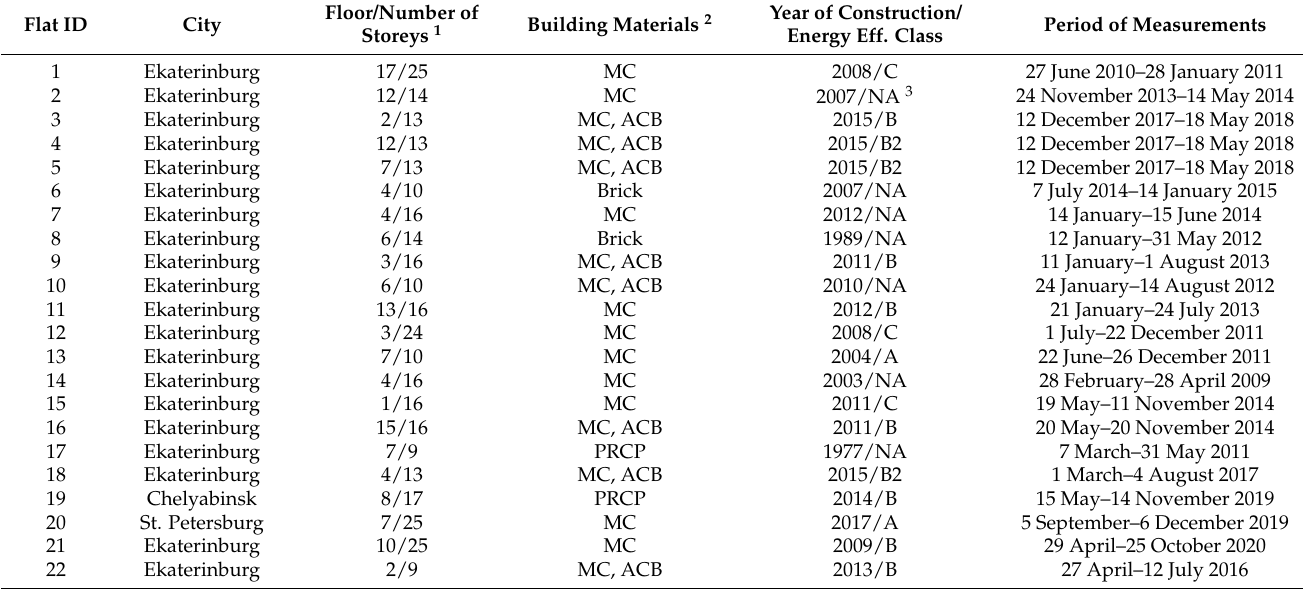
Table 1. Characteristics of flats in which radon series measurements were carried out.